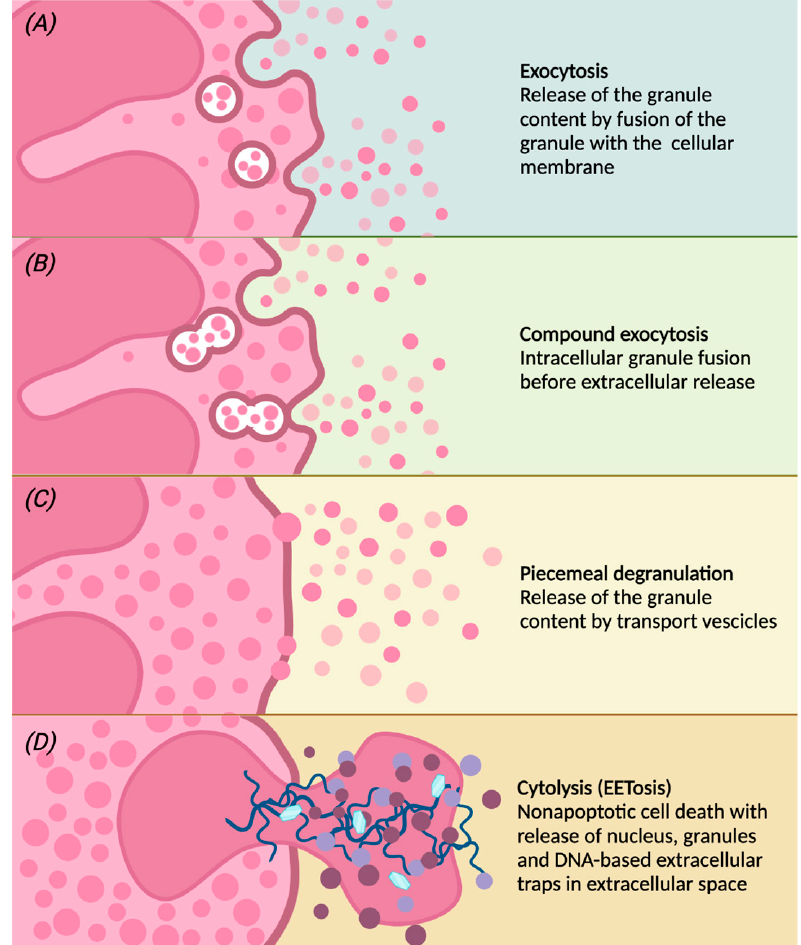
Figure 2. Following different stimulations, eosinophils can release the contents of the granules by classical exocytosis, compound exocytosis, piecemeal degranulation (PMD) or cytolysis. Conventional exocytosis consists of the release of granule content by fusion of the granule itself to the cellular membrane (panel A ). Compound exocytosis is another type of exocytosis in which granules merge with each other before interacting with the cellular membrane (panel B ). Piecemeal degranulation is the progressive and selective release of vesicles from specific granules and the unloading of their contents after the fusion with the cellular membrane (panel C ). Cytolysis is a non-apoptotic form of cell death with rupture of the nuclear and plasma membrane, subsequent release of nuclear DNA and deposition of specific intact granules in the extracellular space. After cytolysis, there may be the release of eosinophilic extracellular traps (EETs), giving this peculiar form of cell death the characteristic name of EETosis (panel D